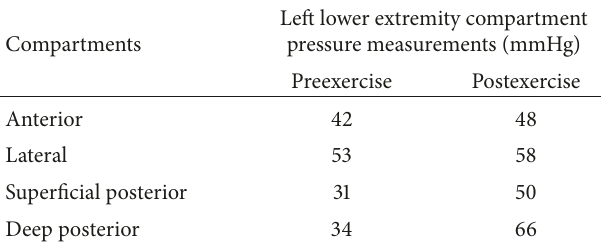
Table 1: Pre- and postexercise compartment pressure measure- ments in the left lower